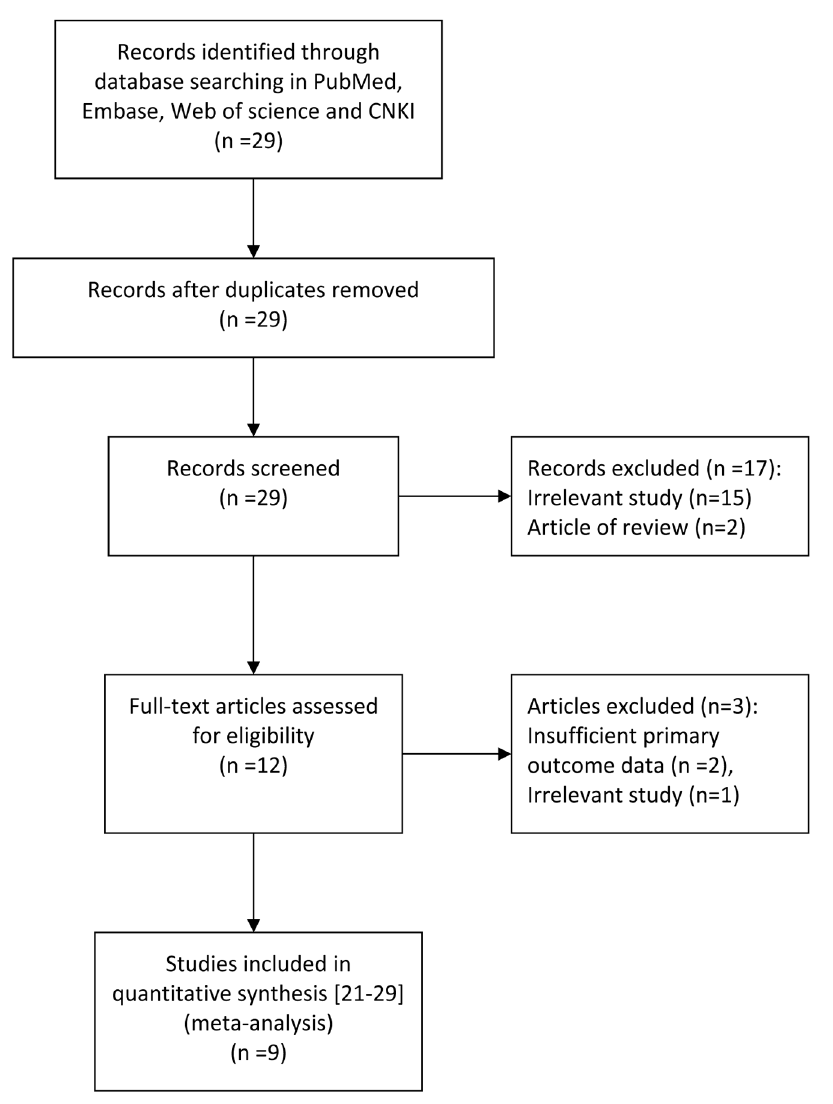
Fig. 1. Flow chart for selection of studies. Excluded studies with the reasons for exclusion were listed in S1 Table.